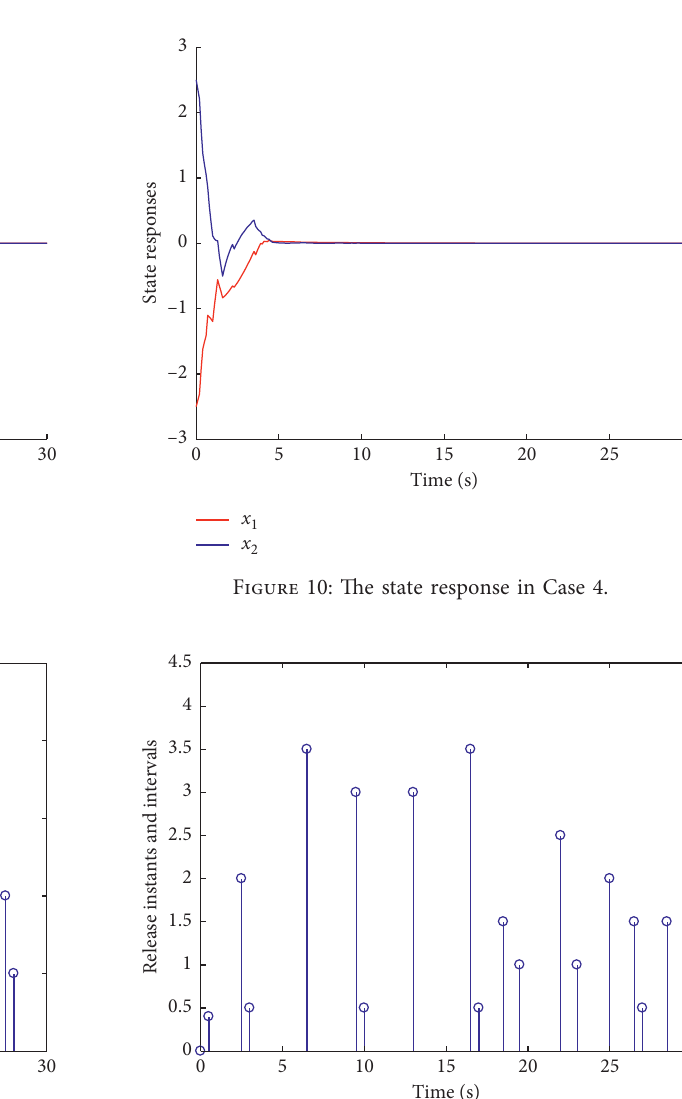
Figure 8: The “event-triggered” of “hybrid-driven” release instants and interval in Case 3.